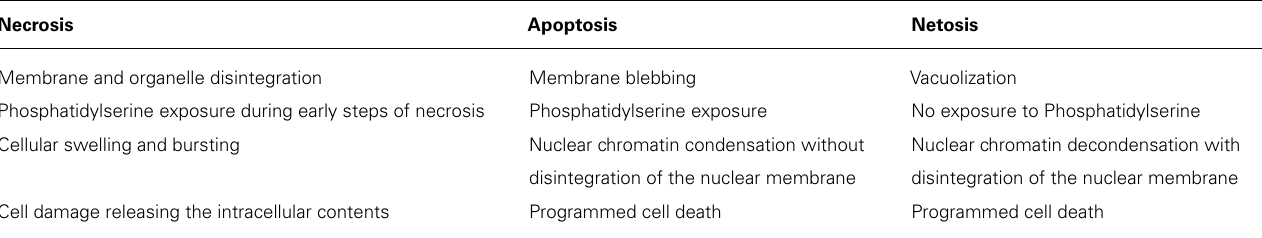
Table 1 | Differences between netosis, apoptosis, and necrosis.